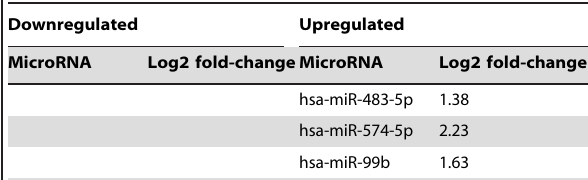
Table 2. Changes in microRNA expression versus control untreated cells.